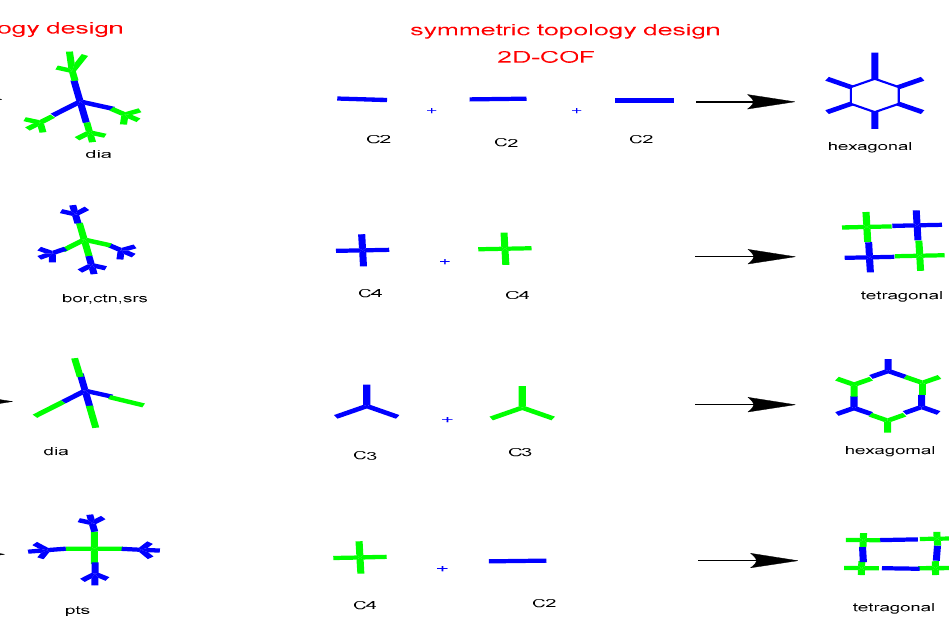
Figure 7. Topology diagram of symmetric and asymmetric linkers reported for COFs synthesis.